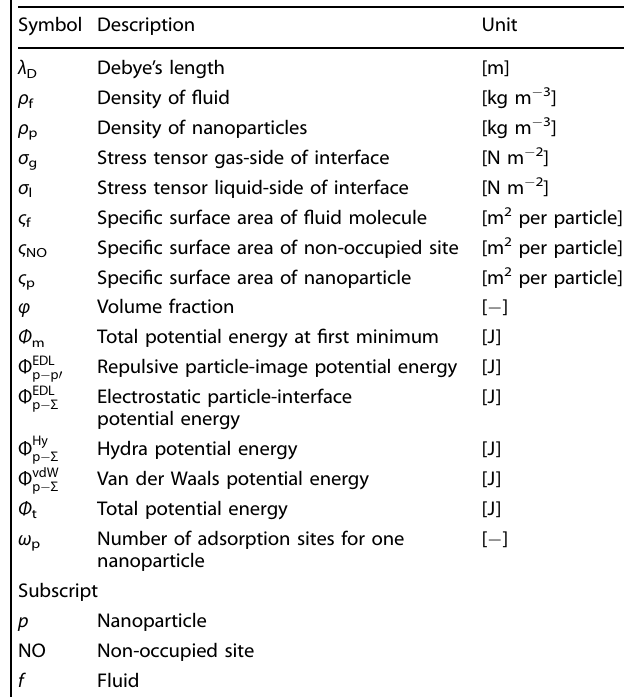
Table 3. Variables used in the model and their